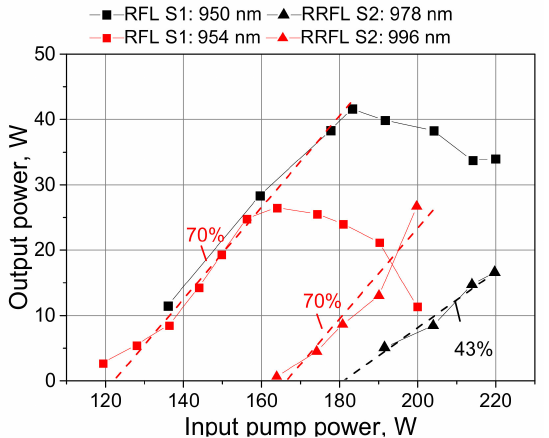
Figure 4. Measured output power of the 1st (squares) and the 2nd (triangles) Stokes waves versus multimode 915 nm LD pump power [16] coupled to the 100 um GIF with linear cavity for the 1st Stokes wave (RFL) and half-open cavity for the 2nd Stokes random RFL (RRFL) versus the input multimode LD pump power at 915 nm at different FBG sets: HR UV FBG + OC FS FBG (RFL) at 950 nm (S1) and HR UV FBG (RRFL) at 978 nm (S2) marked in black; HR UV FBG + OC FS FBG (RFL) at 954 nm (S1) and HR UV FBG (RRFL) at 996 nm (S2) marked in red.